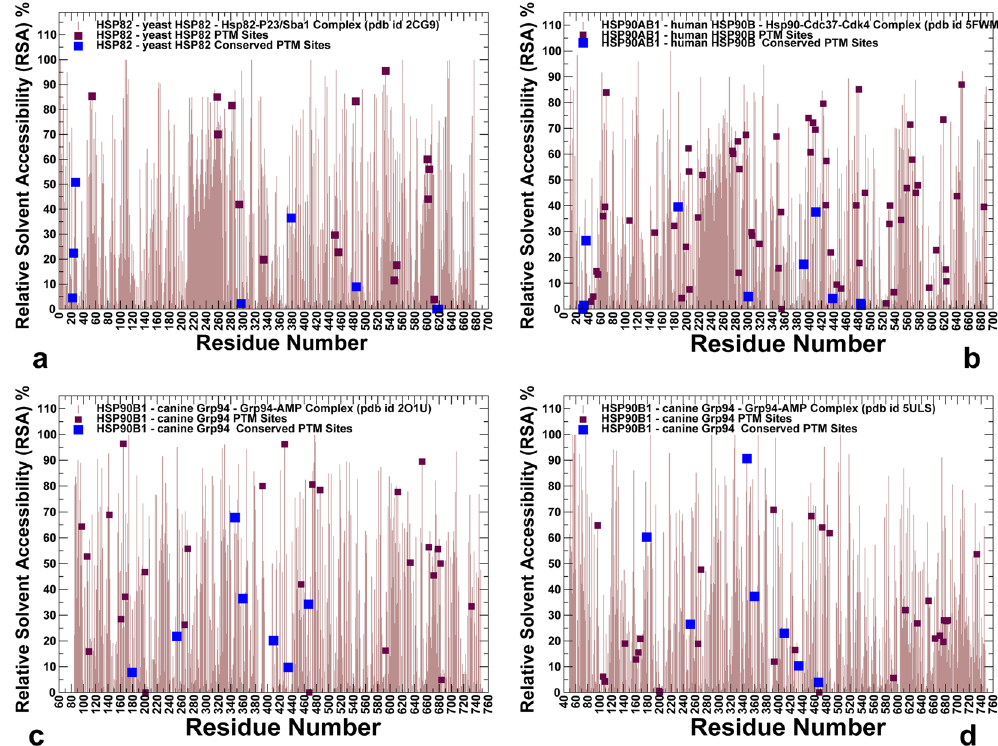
Figure 2. The Relative Solvent Accessibility Profiles of the Hsp90 Structures. The residue-based relative solvent accessibility RSA profiles (in light brown lines) are obtained by averaging computations over the equilibrium trajectories for structures of the yeast Hsp82 ( a ), human Hsp90 β ( b ), and two different structures of canine Grp94 ( c , d ). A residue-specific local RSA measure is defined as the ratio of the observed solvent-accessible surface area for a residue to the expected unfolded state value for that amino acid type. The RSA values for residues corresponding to the experimentally known PTM sites are shown as filled maroon squares and the evolutionary conserved PTM sites are highlighted in filled magenta